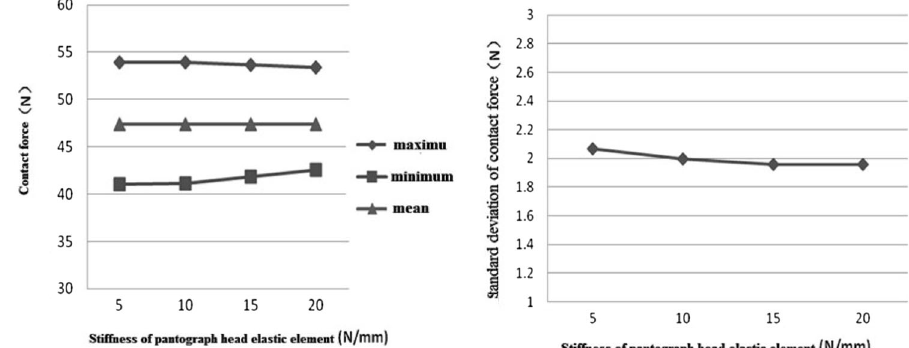
stiffness of right pantograph head elastic element on power collection quality in curved